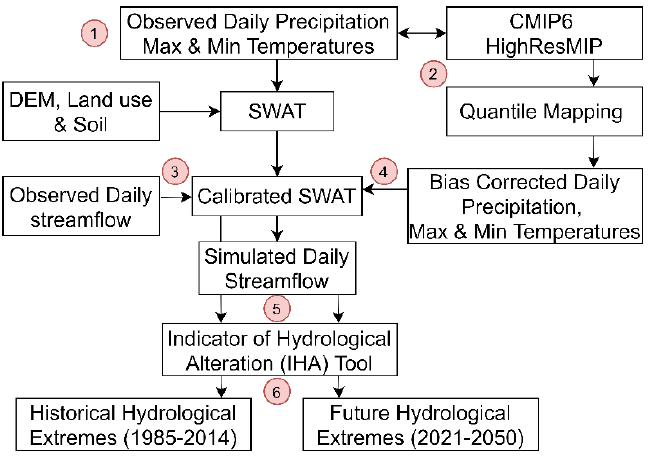
Figure 2. Flow chart of this study.